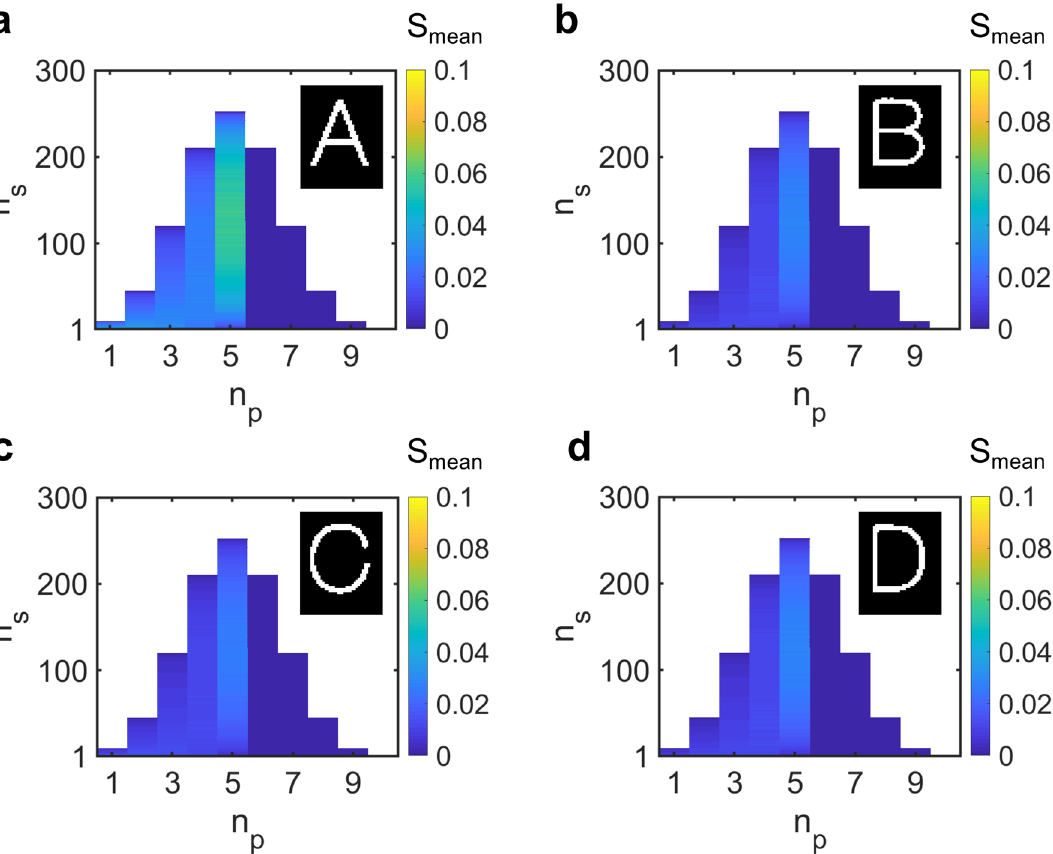
Figure 5. Sophisticated attack based on statistical sampling of key space. ( a–d) Variation of S mean for encrypted letter ‘A’ with n p and n s calculated with respect to letters ‘A’ through ‘D’. S mean for each n p and n s is equal to the mean similarity score of output images obtained by operating 1000 randomly selected keys on the cipher